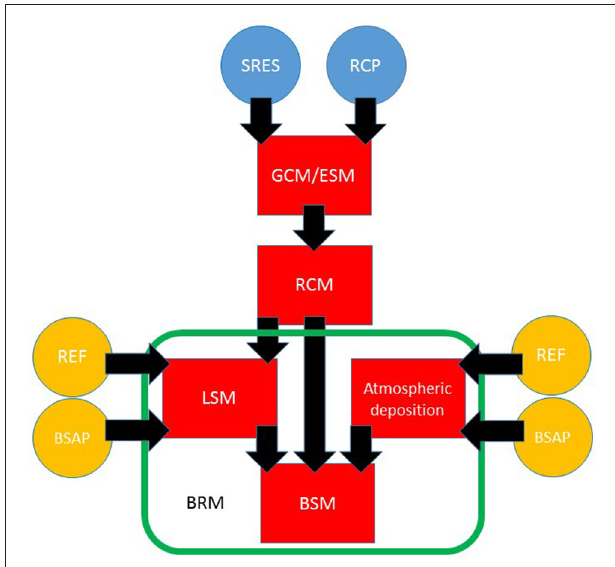
FIGURE 2 | Model hierarchy consisting of a global General Circulation Model (GCM) or Earth System Model (ESM), a Regional Climate Model (RCM), a Land Surface Model (LSM), a Baltic Sea Model (BSM) and scenarios for radiative forcing according to Representative Concentration Pathways (RCPs) or the Special Report on Emission Scenarios (SRES) and nutrient loads (Reference–REF and Baltic Sea Action Plan–BSAP). A Baltic Region Model (BRM) comprises one BSM and one LSM. For details see